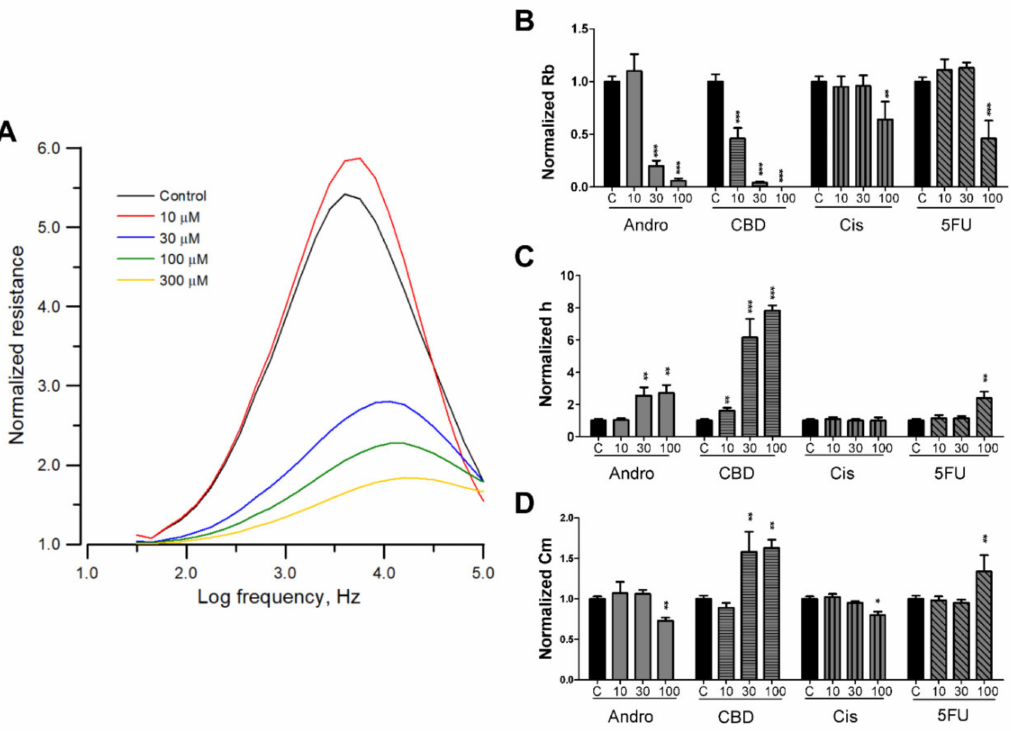
Figure 3. ( A ) Normalized resistance curves as a function of frequency obtained from a frequency-scan measurement 24 h after the addition of andrographolide to confluent SCC-25 cell layers at various concentrations of 10 µ M (red), 30 µ M (blue), 100 µ M (green), 300 µ M (yellow), and control (black). Changes in morphological parameters of confluent SCC-25 cell layers upon challenge with di ff erent concentrations of andrographolide, CBD, 5-FU, and cisplatin, respectively. Normalized junctional resistance between cells ( B ), average cell–substrate separation ( C ), and membrane capacitance ( D ) of the SCC-25 cell layers were obtained through cell-electrode model calculation of the frequency-scan data. Six independent frequency scan experiments were performed (n = 6). In each experiment, two or three wells were measured for each drug concentration. Values shown are mean ± standard